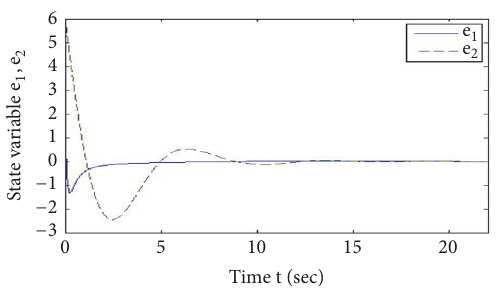
Figure 3: General process.